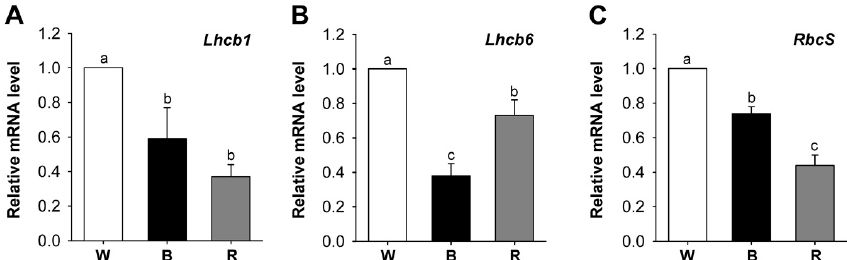
Figure 6. Effects of different wavelengths of LEDs on the expression of nuclear-encoded photosynthetic genes encoding the chlorophyll-binding proteins. ( A ) Lhcb1 ; ( B ) Lhcb2 ; and ( C ) RbcS . The plants were subjected to the same treatments as in Figure 2. Treatment notations are the same as in Figure 2. Total RNAs were purified from plants and reverse transcribed. The resultant cDNAs were used as templates for qRT-PCR using Actin as an internal control. The white LED (control) was used for normalization, with the expression level of the sample set to 1. Error bars indicate SEM from three independent experiments ( n = 3); each experiment has three biological replicates. Means denoted by the same letter did not differ significantly at p < 0.05 according to Duncan’s multiple range test.